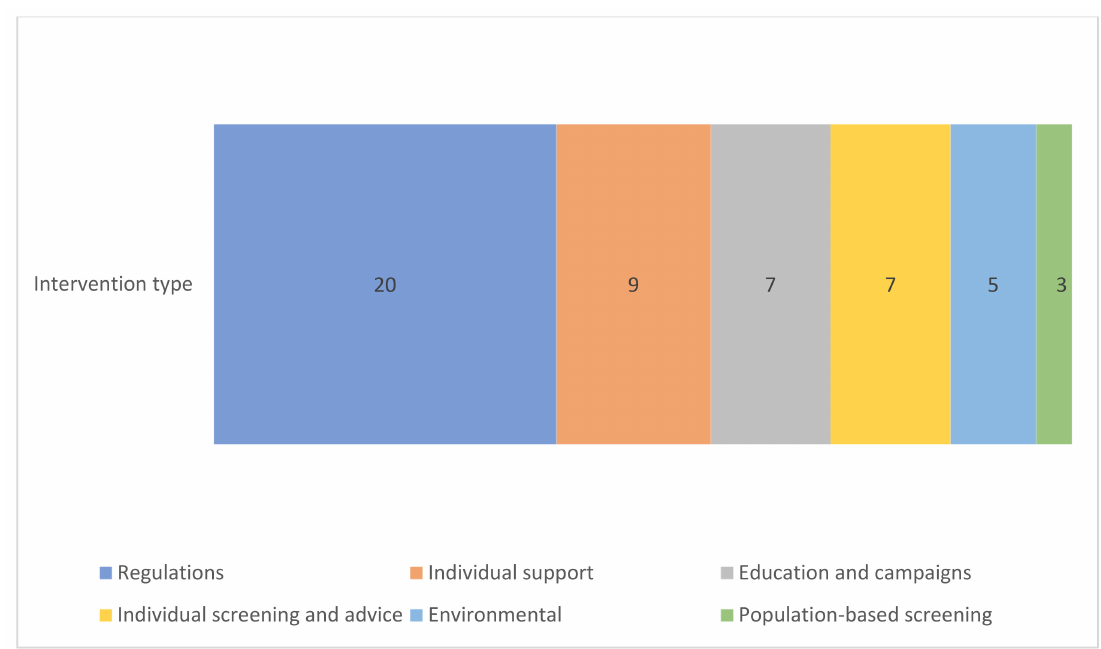
Figure 2. Types of interventions in the 51